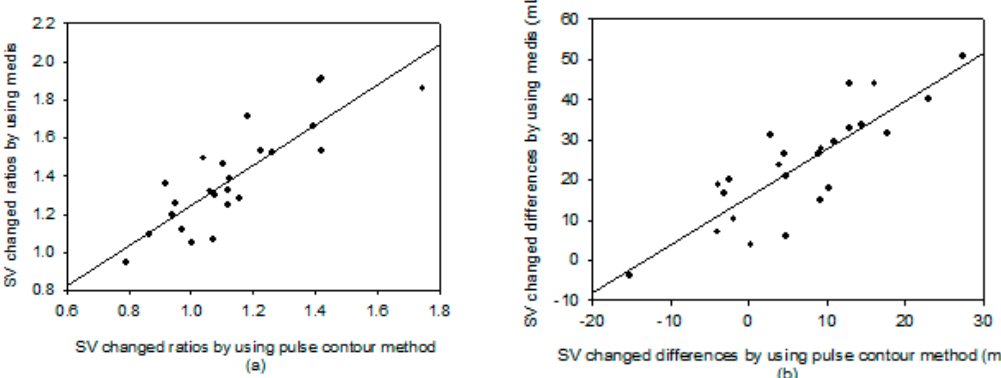
Figure 4. The SV with using the pulse contour method and the Medis, correlation coefficient, r 2 = 0.237.